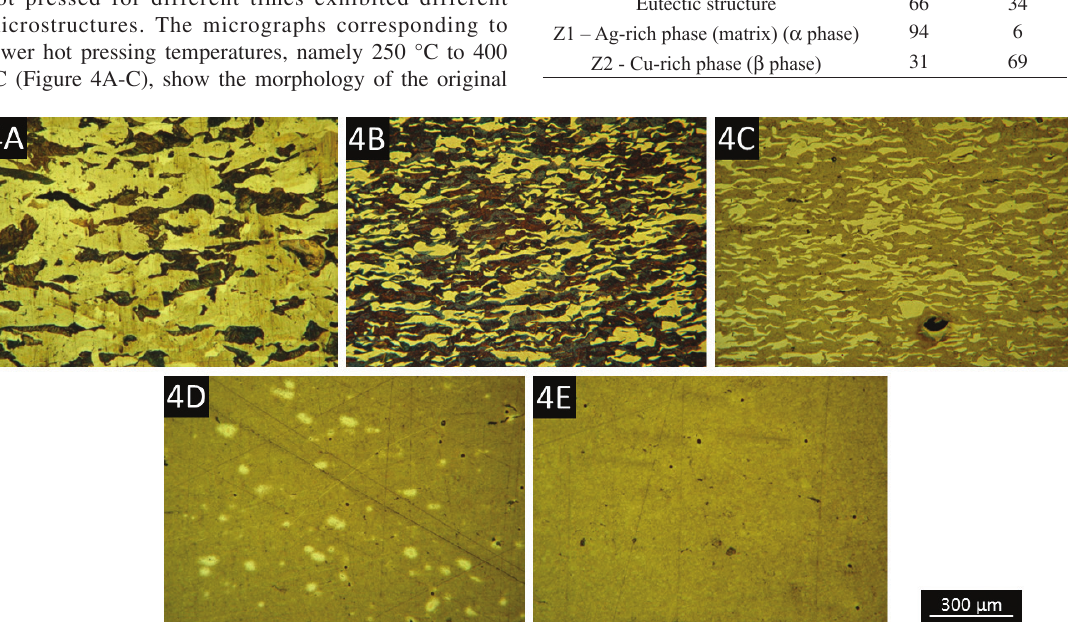
Figure 4. Microstructures of the hot pressed sterling silver processed at a pressure of 35MPa for 60 minutes at different temperatures: A) 250 °C; B) 300 °C; C) 400 °C; D) 500 °C and E) 700 °C.